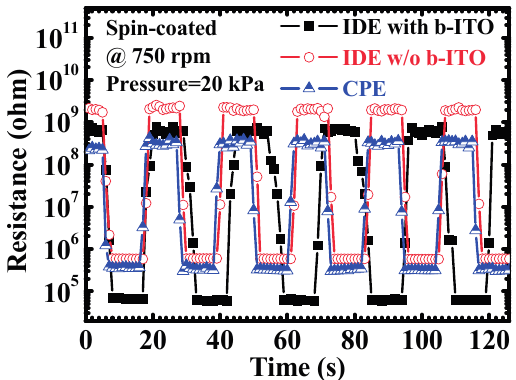
Figure 7. Reversible testing of poly(3,4-ethylenedioxythiophene):polystyrene sulfonate (PEDOT:PSS) pressure sensors with inter-digitated electrode (IDE) and cross-point electrode (CPE) structures for at least five loops. The PEDOT:PSS spin-coating speed of 750 rpm and the applied pressure of 20 kPa under a 10-s holding time were used for the